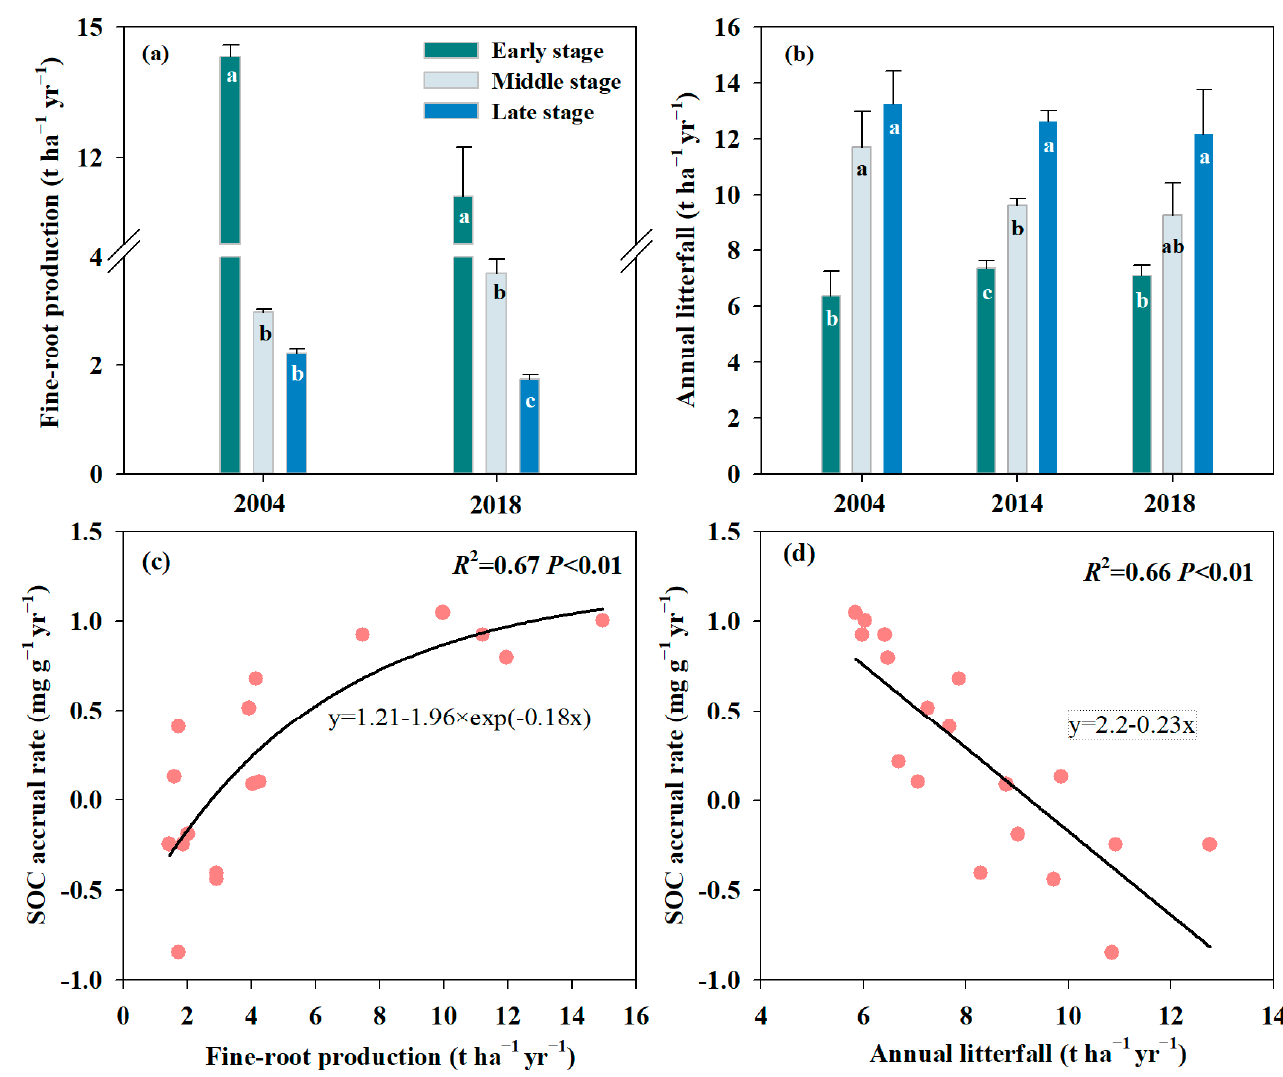
Figure 3. Long-term changes in fine-root production (panel ( a )) and litterfall biomass (panel ( b )) across forest succession, as well as their relationship with SOC accumulation rates. Fine-root produc- tion (panel ( c )) and litterfall biomass (panel ( d )) were measured in 2018. Different lowercase letters indicate significant differences among successional stages, p < 0.05. Dots and bar charts represent mean values, vertical bars represent the standard